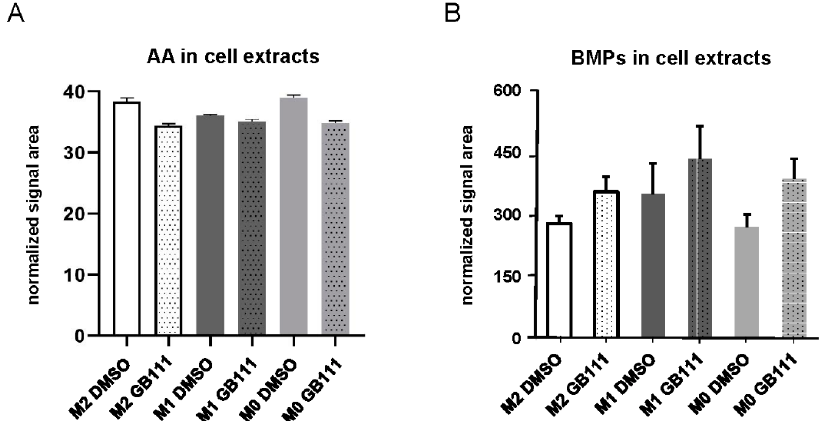
Figure 4. ( A ) Mass spectrometric analysis showing relative changes in arachidonic acid (AA) in cell lysates of human M0, M1, and M2 macrophages treated with GB111-NH 2 or DMSO. Profiles of AA were normalized to the sum of all measured fatty acids signals (percent of total). Error bars represent SD of three technical replicates. ( B ) Mass spectrometric analysis showing changes in Bis(monoacylglycero)-phosphate (BMP) in the cell lysates of human M0, M1, and M2 macrophages treated with GB111-NH 2 or DMSO. Data were normalized against the area of the signal of the externally added standard (BMP14:0/14:0). Error bars represent SD of three technical replicates.